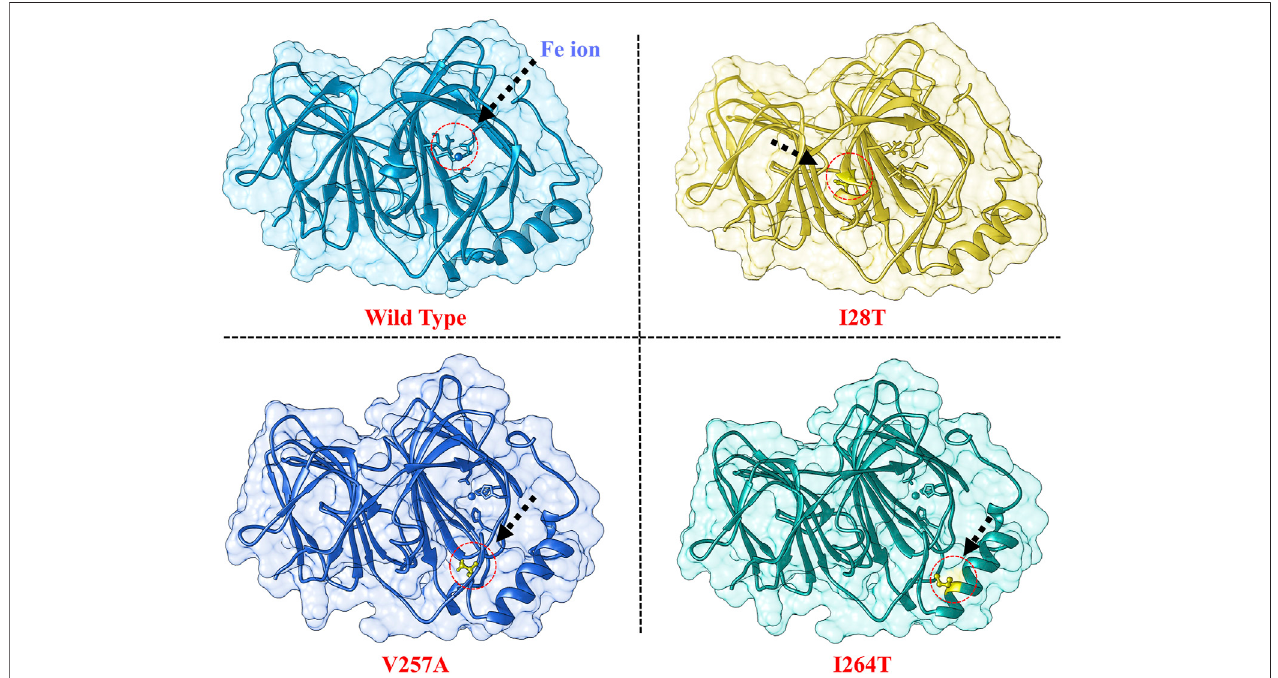
FIGURE1| Modeled3DstructuresoftheWTandI28T,V257A,andI264Smutants.Themodeledmutationsareencircledtoshowtheirposition.TheFeionbinding is also shown.